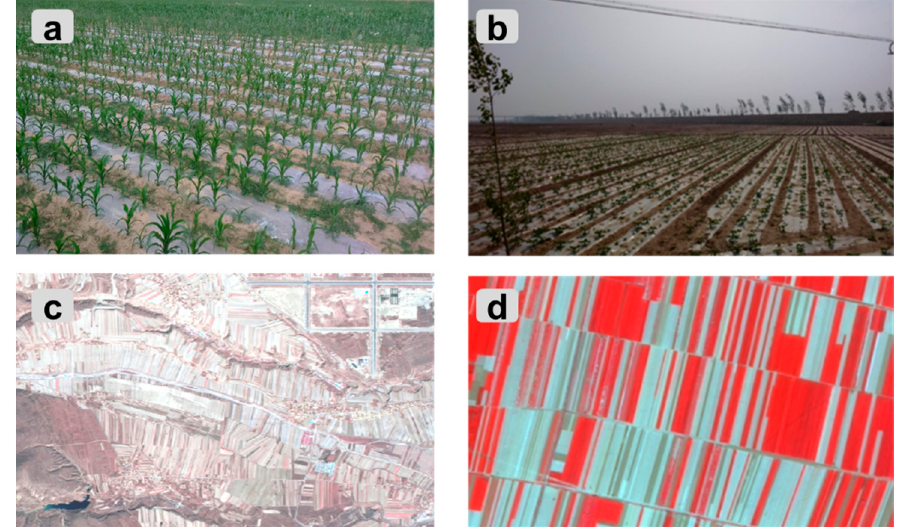
Figure 10. The photo and GF-1 image showing PMF in Jizhou and Guyuan: ( a ) field photo of PMF in Guyuan; ( b ) field photo of PMF in Jizhou; ( c ) GF-1 image of PMF in Guyuan; ( d ) GF-1 image of PMF in Jizhou; two GF-1 images are displayed in false color composite (R: NIR, G: red, B: green).